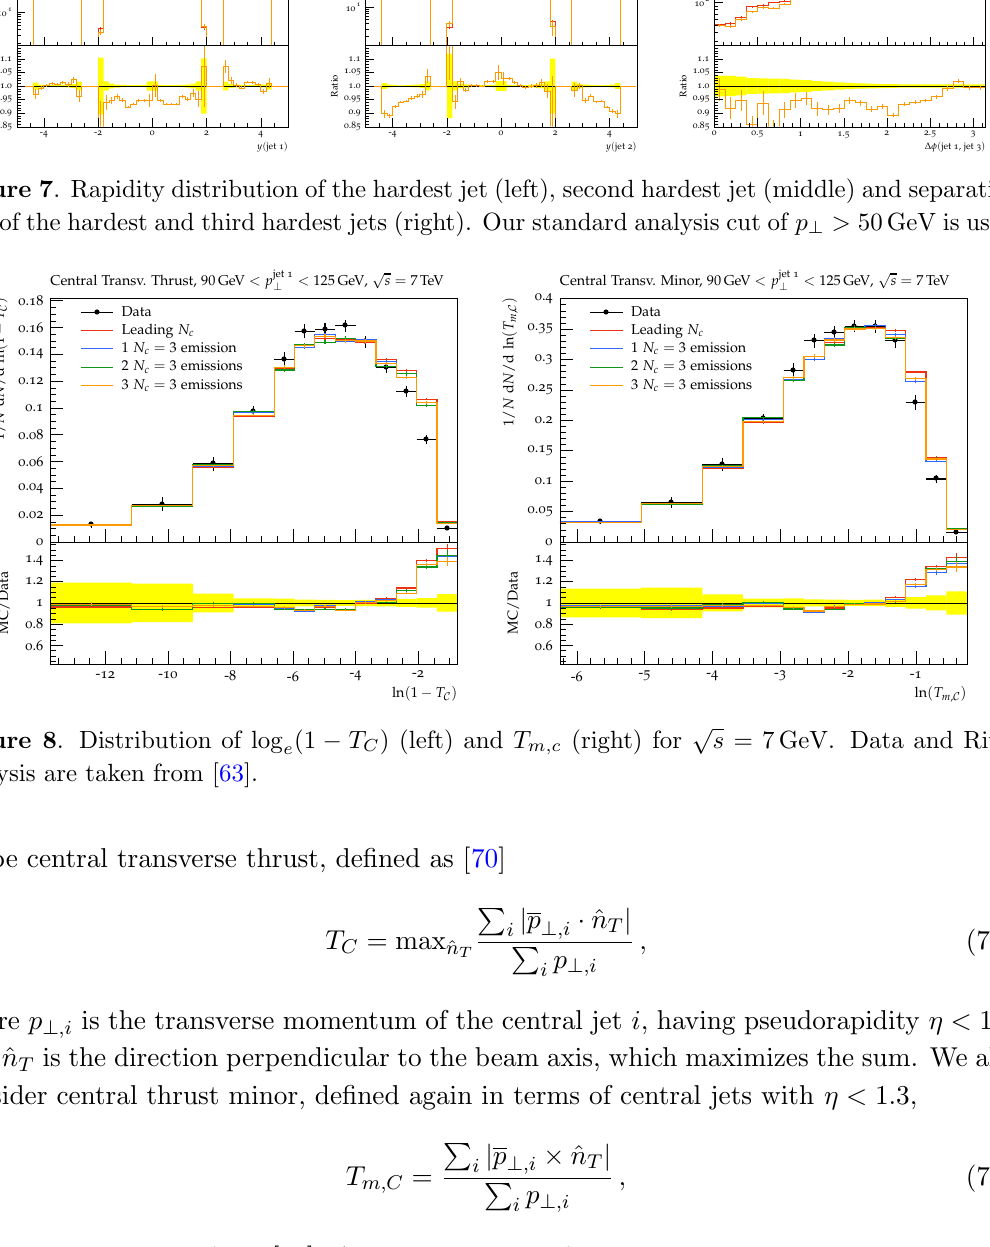
(1 T C ) (left) and T m;c (right) for p s = 7 GeV. Data and Rivet e (cid:0)